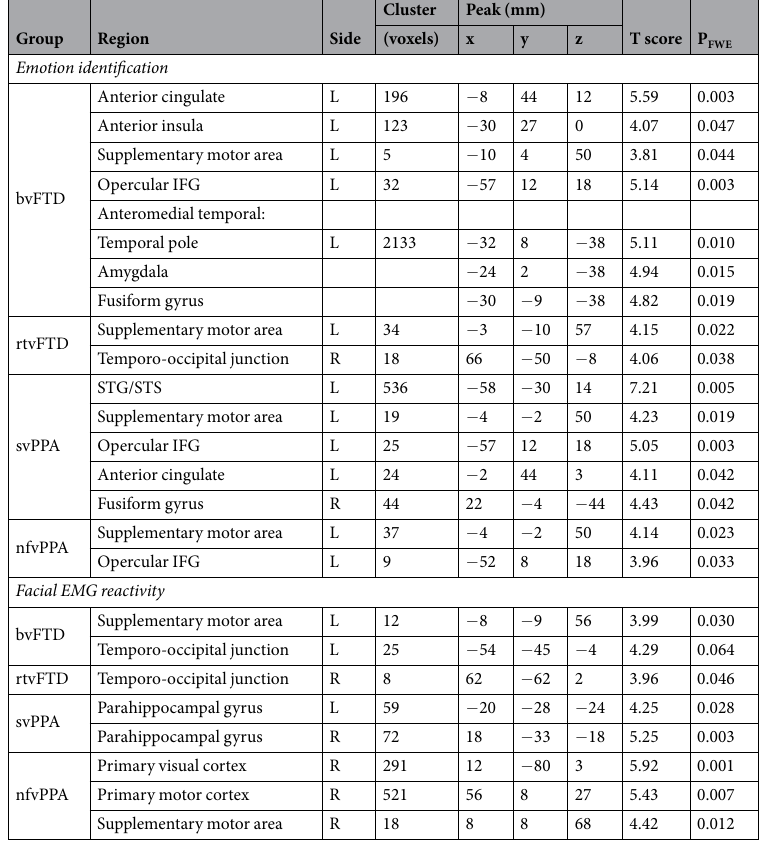
Table 3. Neuroanatomical correlates of emotion identification and reactivity in patient groups. The table presents regional grey matter correlates of mean overall emotion identification score and facial EMG reactivity (as defined in Fig. 1) during viewing of facial expressions in the four patient groups, based on voxel-based morphometry. Coordinates of local maxima are in standard MNI space. P values are all significant after family- wise error (FWE) correction for multiple voxel-wise comparisons within pre-specified anatomical regions of interest (see text). bvFTD, patient group with behavioural variant frontotemporal dementia (excluding right temporal cases); IFG, inferior frontal gyrus; nfvPPA, patient group with nonfluent variant primary progressive aphasia; rtvFTD, patient subgroup with right temporal variant frontotemporal dementia; STG/S,